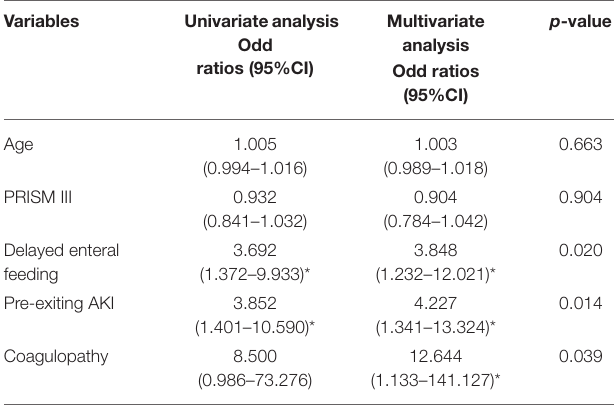
hypertensive crisis (17.1%). Twenty-nine patients (41.1%) had pre-existing AKI stage 2 or above. Two patients who